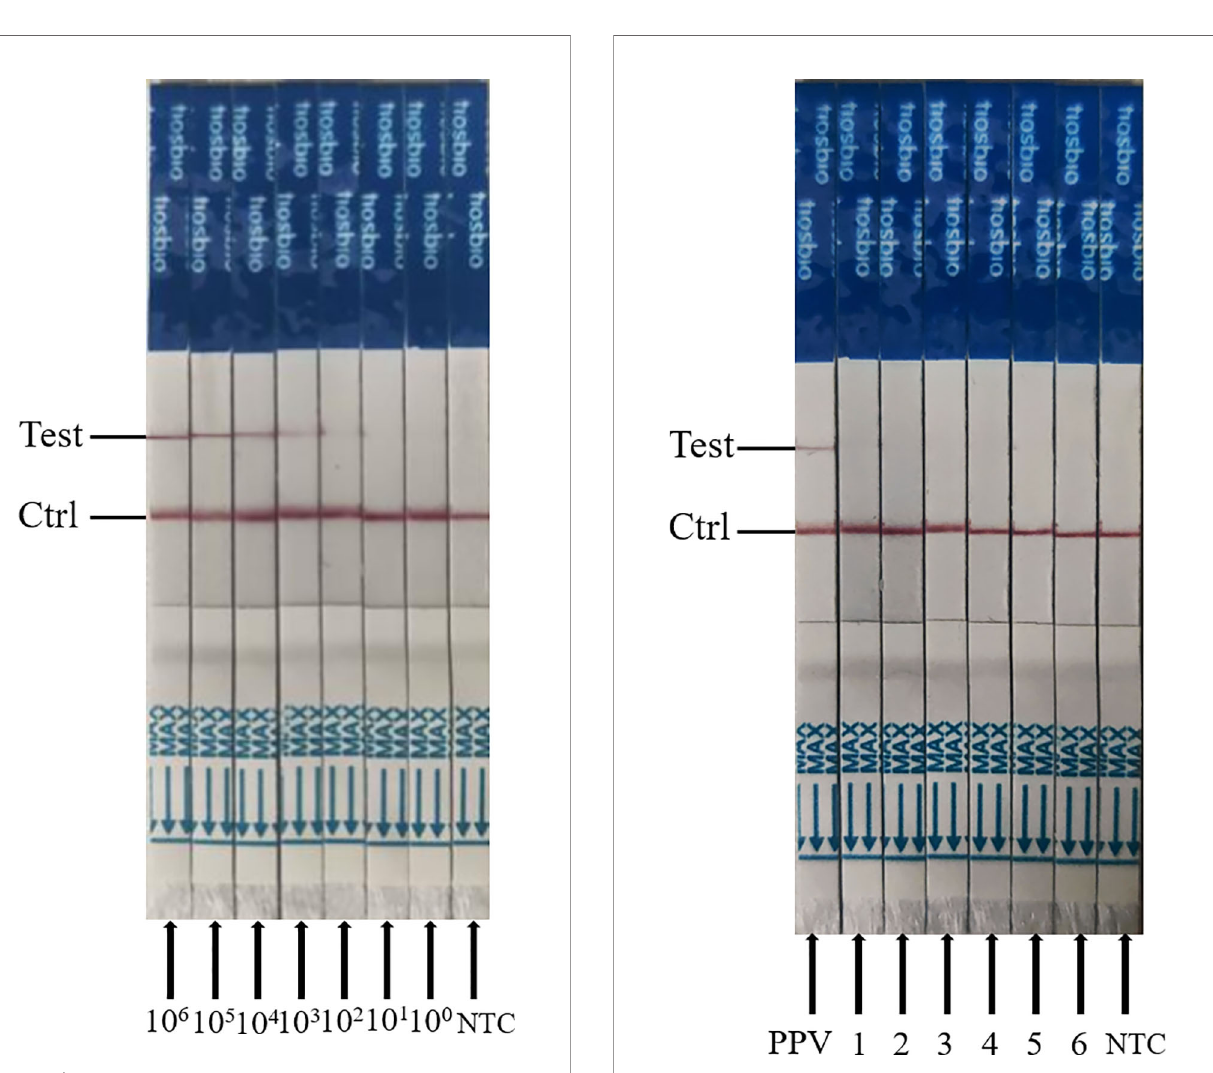
FIGURE 7 | Analytical speci fi city result of the ERA-CRISPR/Cas12a assay. From left to right, the test samples are positive samples of PPV; 1, PPV-2; 2, PCV3; 3, porcine pseudorabies live vaccine (PRV, HB-98 strain); 4, swine fever live vaccine (CSFV, AV1412 strain); 5, porcine epidemic diarrhea live vaccine (PEDV, ZJ08 strain); 6, porcine reproductive and respiratory syndrome live vaccine (PRRSV, R98 strain); NTC, negative control of RNase- free ddH 2 O.